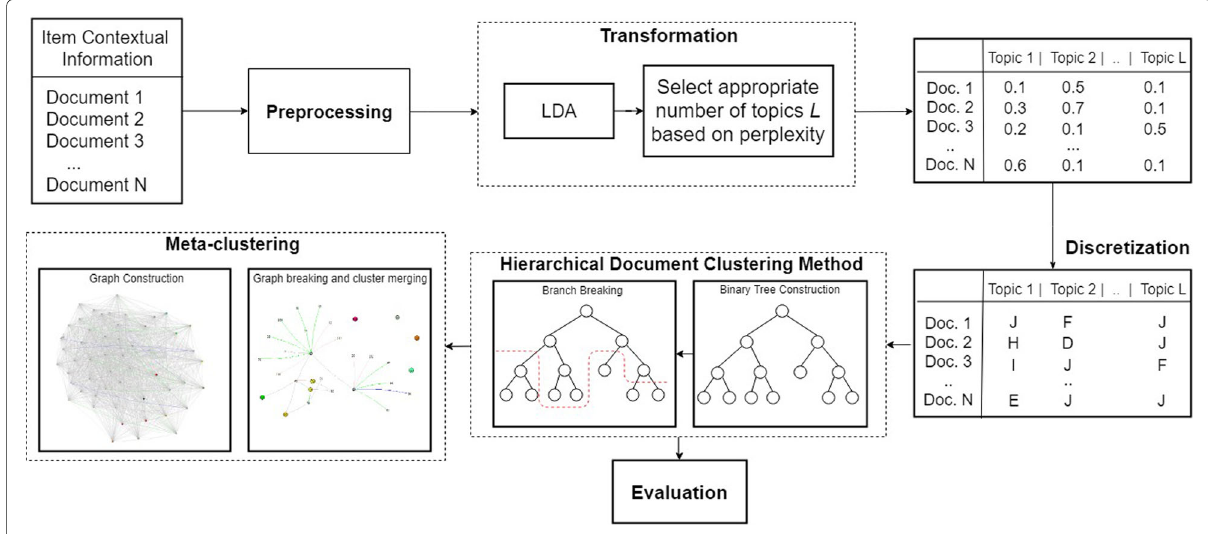
Fig. 1 The proposed framework for hierarchical document